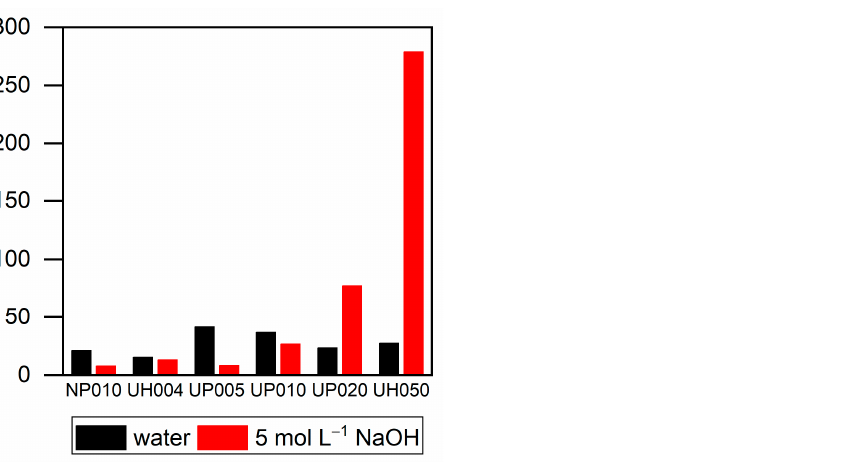
Figure 5. Permeance of water and 5 mol L − 1 sodium hydroxide with different ultrafiltration mem- branes at 40 °C. NP010 and UH004 at a pressure of 15 bar; UP005, UP010, and UP020 at a pressure of 10 bar; and UH050 at a pressure of 5 bar.